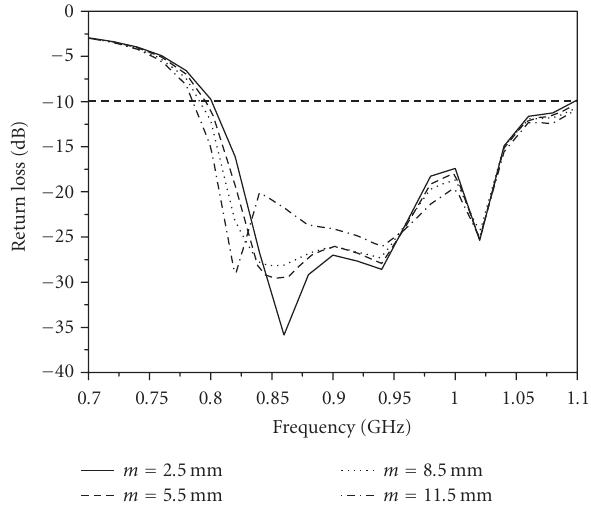
Figure 7: E ff ect of varying extensions of the feed lines on impedance matching.